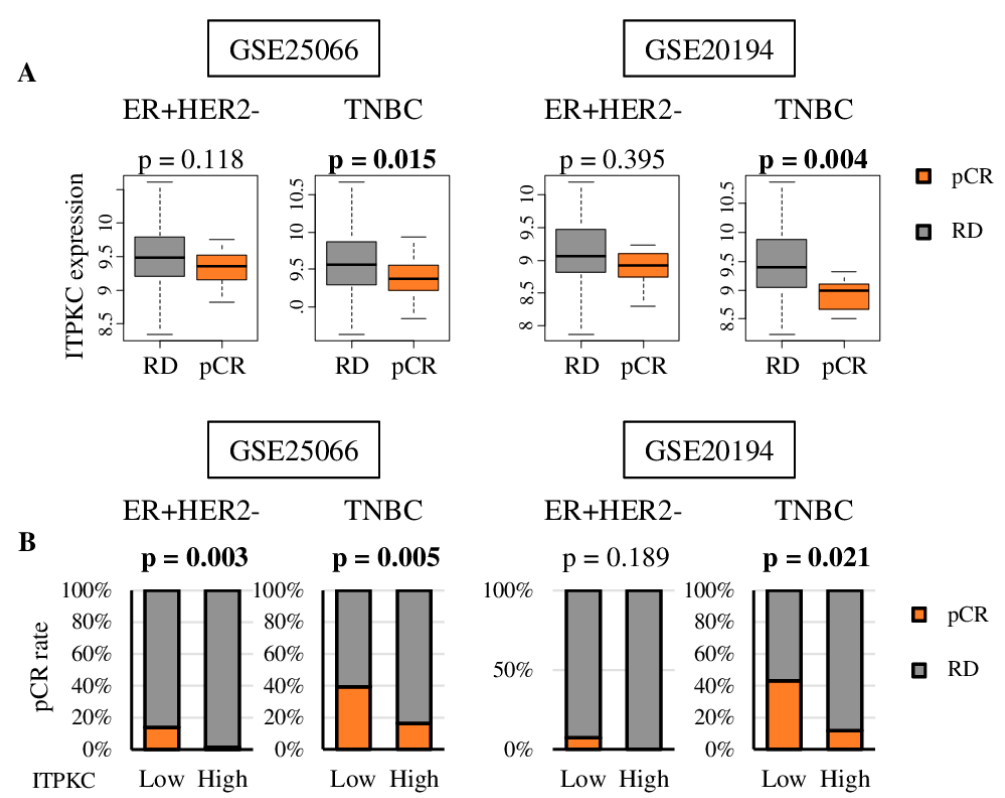
Figure 5. ITPKC gene expression and treatment response in ER+/HER2- and TNBC patients. ( A ) Boxplots of the ITPKC expression of residual disease (RD) and pathological complete response (pCR) after NAC in GSE25066 ( n = 467) and GSE20194 ( n = 197) cohorts. One-way ANOVA test was used to calculate p values. ( B ) pCR rate after NAC by low and high ITPKC expression in ER+/HER2- and TNBC in same two cohorts. The top quartile was defined as the high-score group within each cohort. Fisher’s exact test was used to calculate p values.